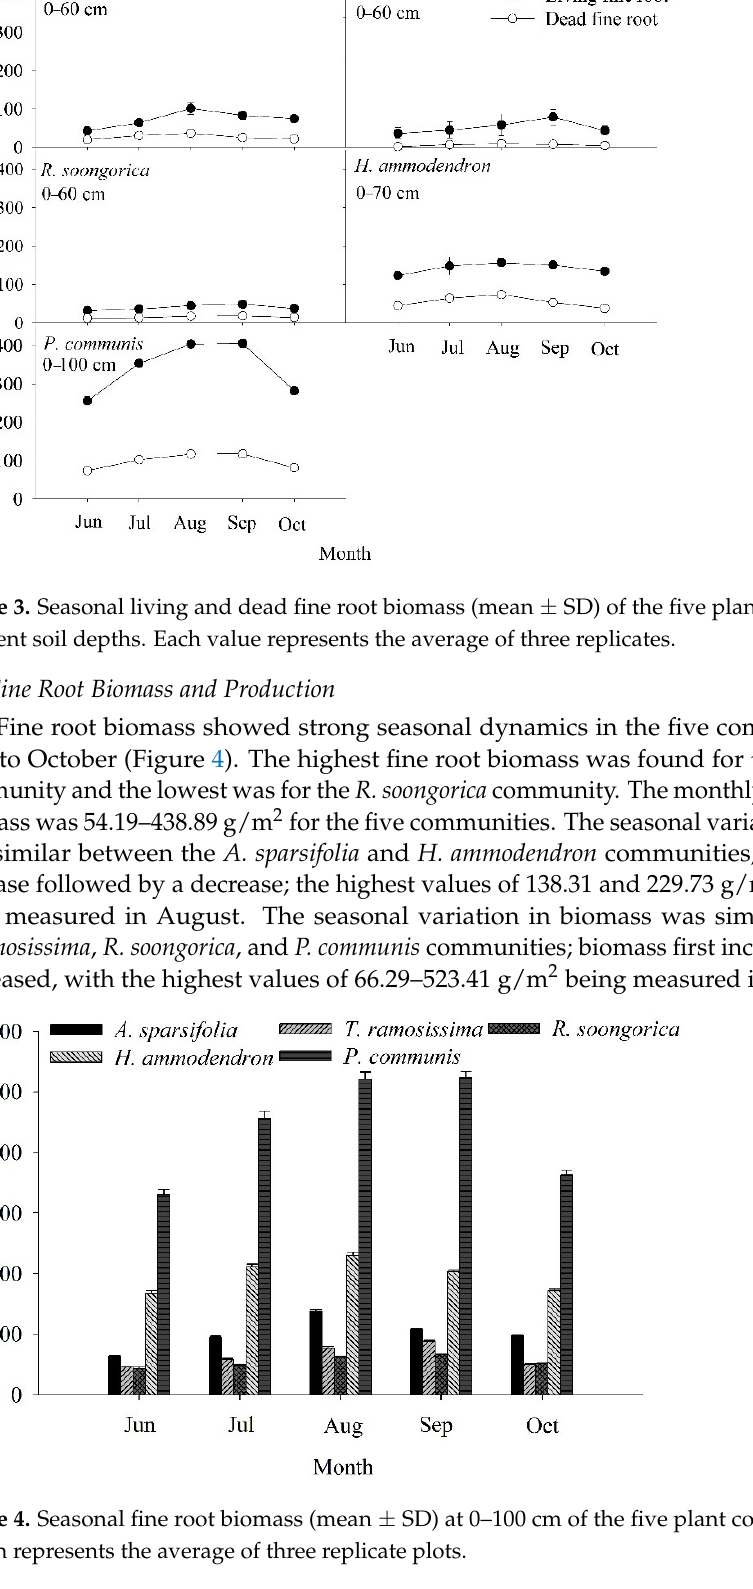
Figure 5. SOC (mean ± SD) of the five plant communities at soil depths of 0–100 cm. Each value represents the average of 3 three replicates. The β values of the SOC ranged from 0.9472 to 0.9570 for the five communities (Figure 6). Among all communities, the accumulation of SOC with soil depth differed significantly (Figure 5). The mean SOC value was only 74.36% for the H. ammodendron , T. ramosissima , R. soongorica , and P. communis communities at 0–30 cm, whereas for the A. sparsifolia com- munity, 80.36% of the SOC was distributed in the 0–30 cm soil layer. The SOC contents in the five communities varied strongly with seasons (Table 2). The highest monthly mean values of SOC occurred in the A. sparsifolia community and the lowest ones in the P. communis community. The monthly average values were 1.65–2.89 g/kg for the five communities. The highest SOC values of the A. sparsifolia (3.08 g/kg), T. ramosissima (2.35 g/kg), and R. soongorica (2.34 g/kg) communities were found in June, and